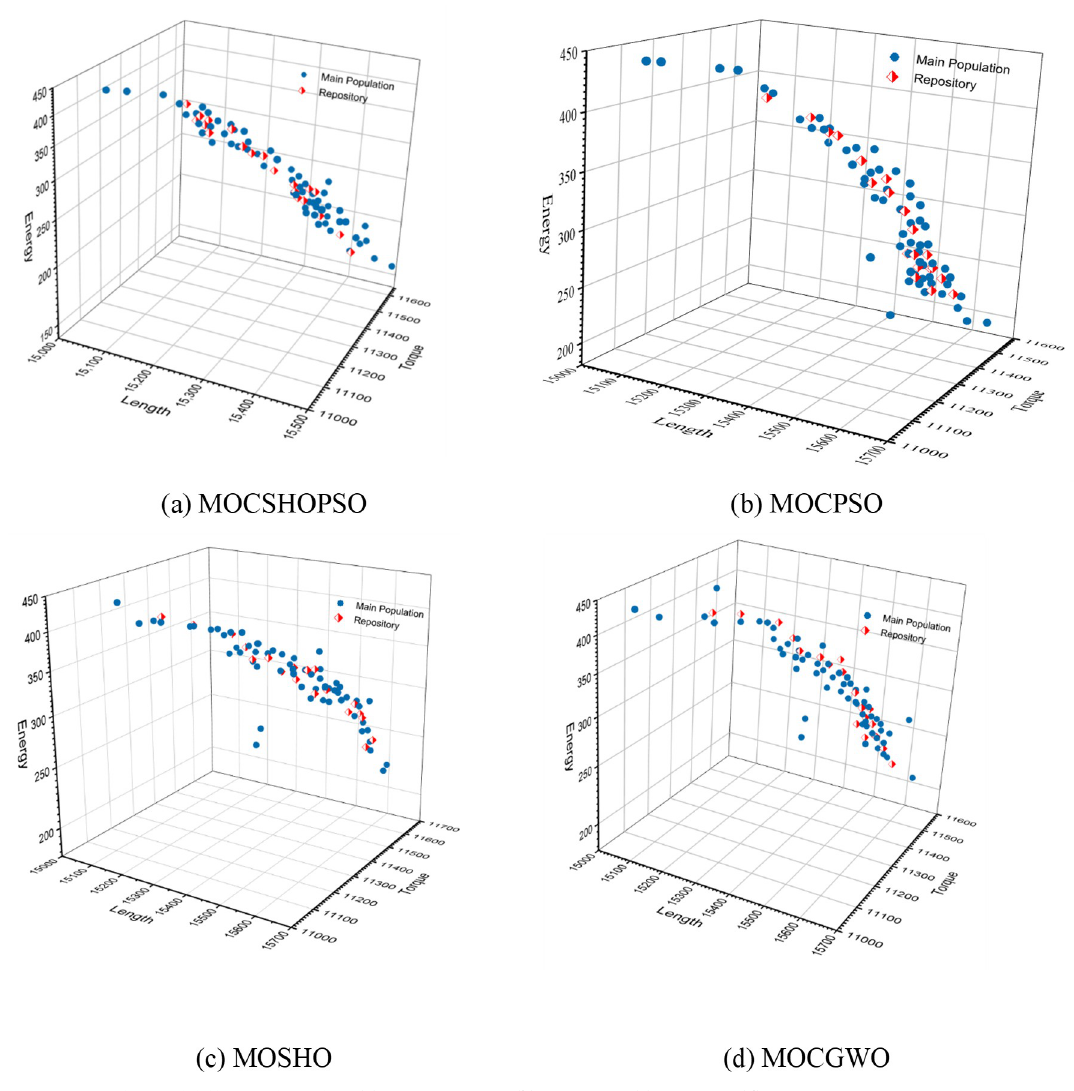
Fig 4. Pareto front of different algorithm. (a) MOCSHOPSO. (b) MOCPSO. (c) MOSHO. (d) MOCGWO.